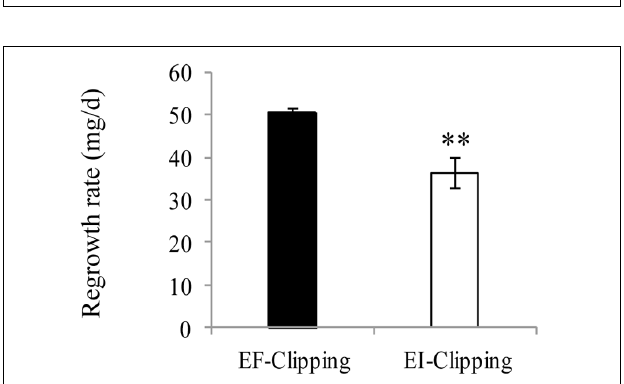
FIGURE 6 | Comparison of regrowth rate of EF and EI A. sibiricum under the clipping treatment. The asterisk denotes means that are significantly different ( P <